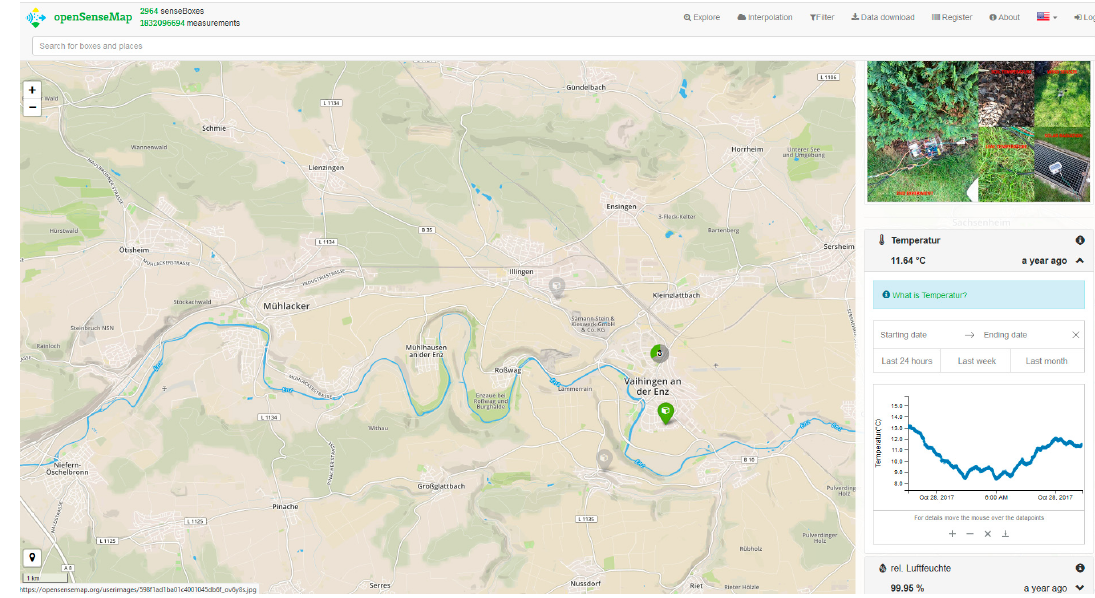
Figure A2. Screenshot of the OpenSenseMap web server visualization of the measurement experiment at the green roof structure in Illingen, Germany (https://opensensemap.org/explore/598f1ad1ba01c4001045db6f).